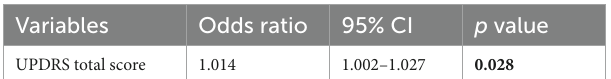
TABLE 3 Predictors of fatigue in